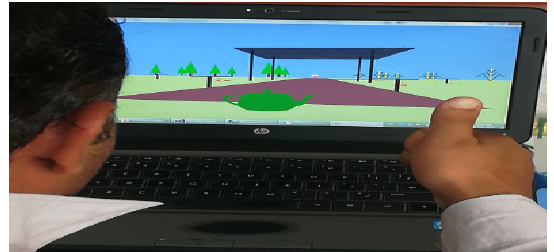
Fig. 13(a): Horizontal Movement (b) Scaling about the x-axis